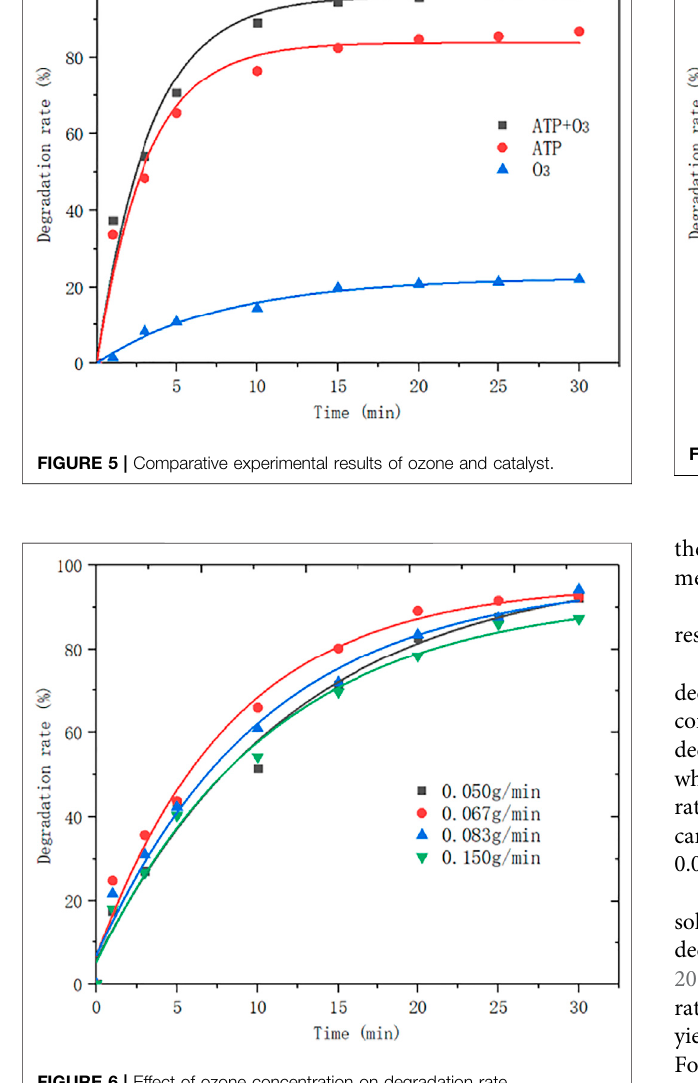
FIGURE 6 | Effect of ozone concentration on degradation rate.